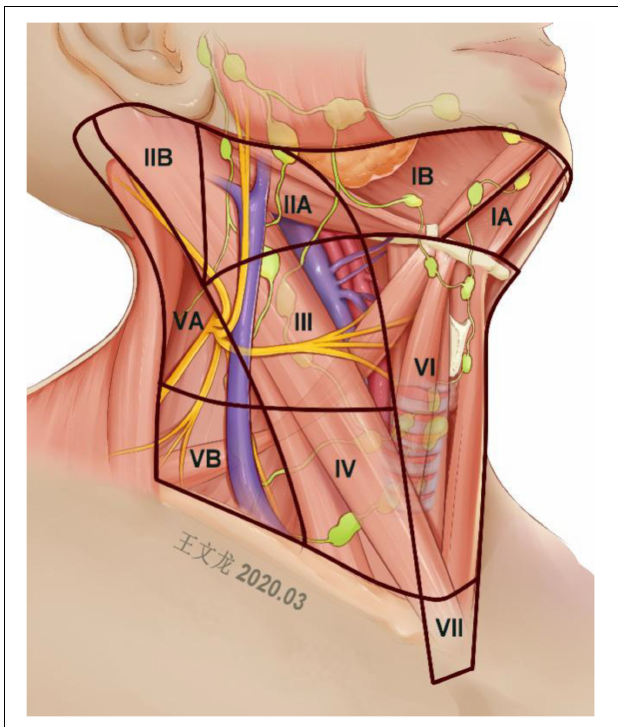
FIGURE 1 | Anatomic levels of the neck dissection.